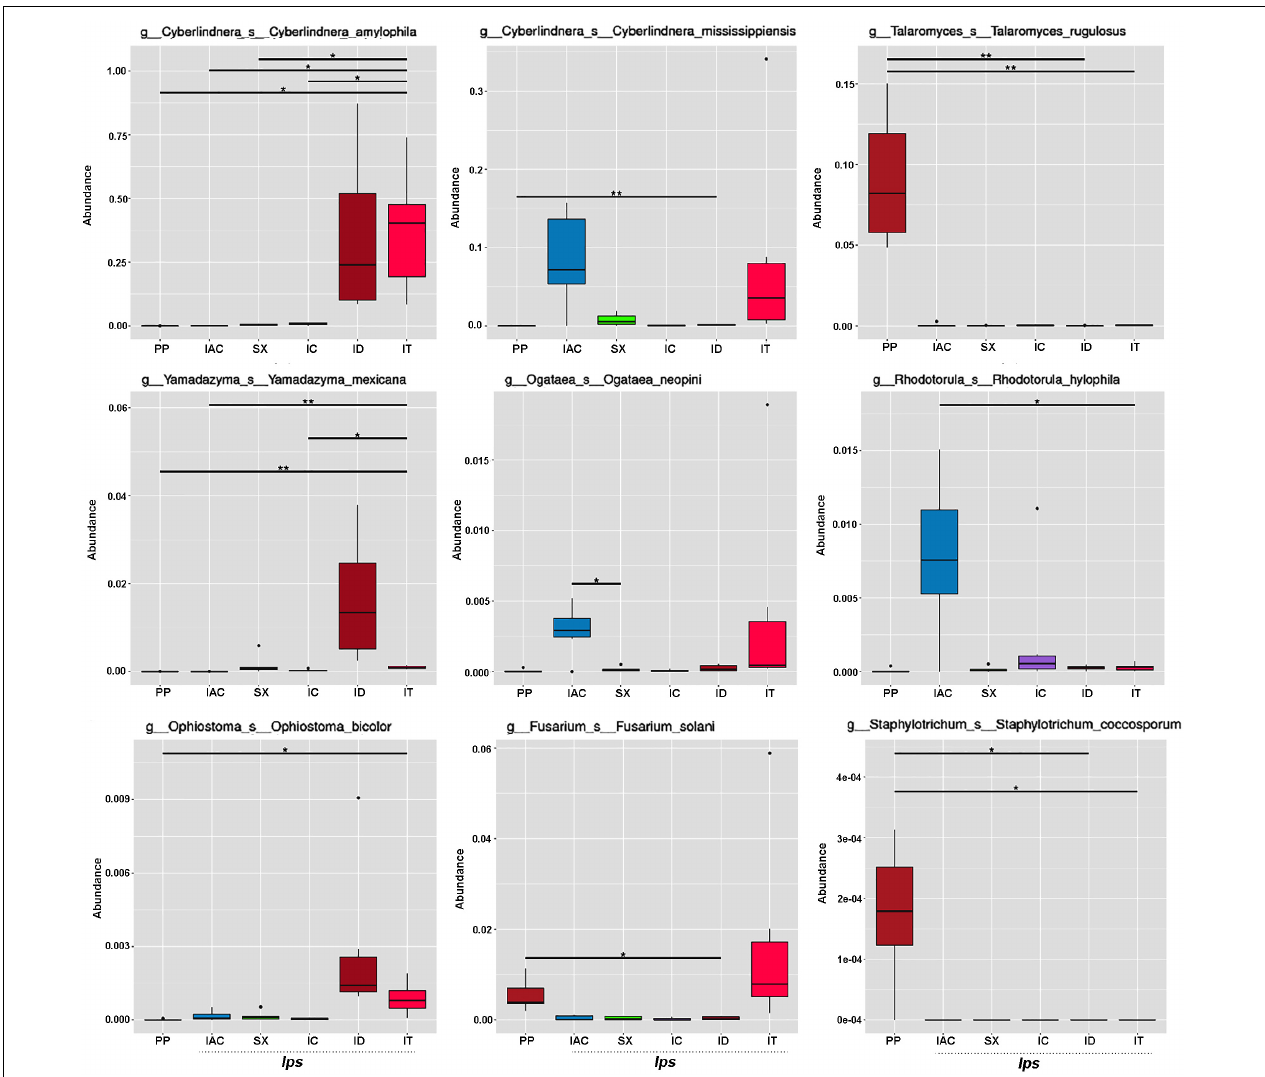
FIGURE 6 | Metastats analysis. The barplot represents the fungal species-specific variation (top 9 species) in the gut of the bark beetles. The significant differences in species abundance among beetles are evaluated by the FDR test. The horizontal line designates the two groups with significant variation. “*” represents significant difference at q < 0.05 while “**” denotes significance at q <